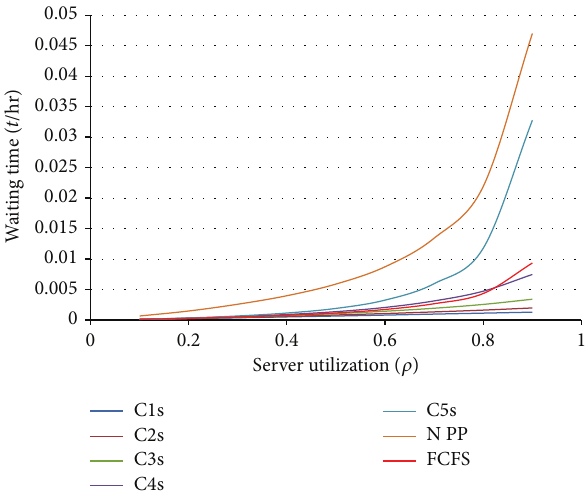
Figure 5: Performance of non-preemptive priority and